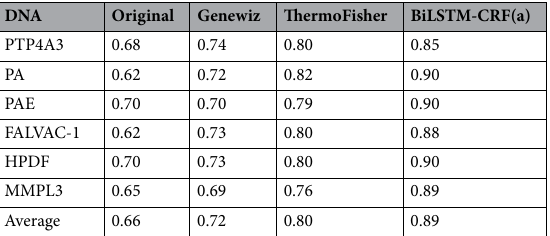
Table 3. Comparative analysis of Jaccard similarity. Jaccard similarity index between the optimized sequences of BiLSTM-CRF(b) and others.